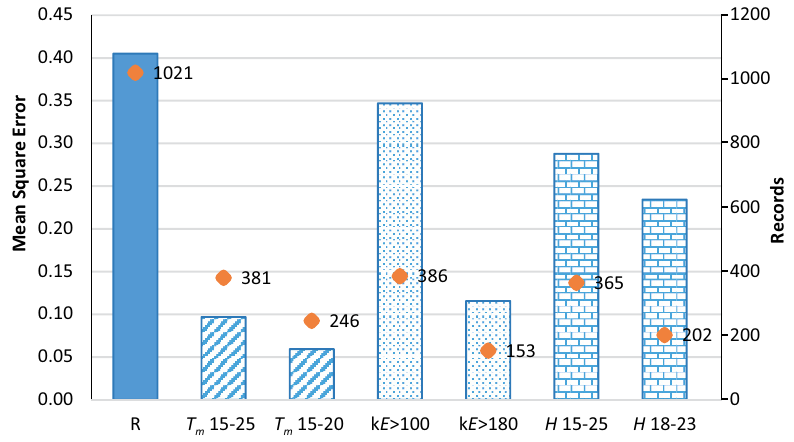
Figure 7. Mean Square Error for different homogeneous